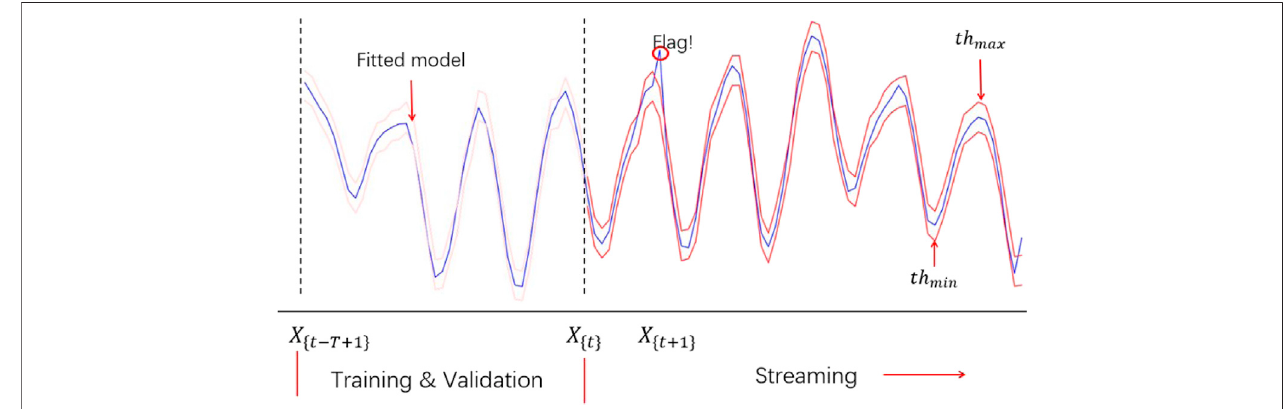
FIGURE 4 | Schematic diagram of anomaly